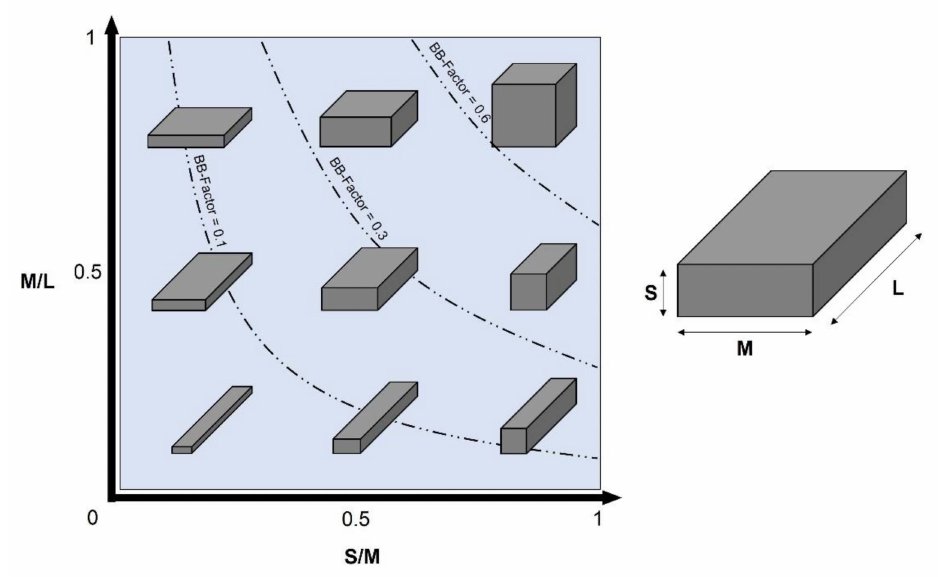
Figure 4. Definition of bounding-box factor ( BB-factor